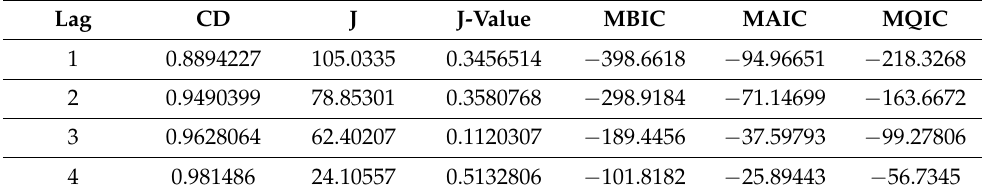
Table 6. Moment and Model Selection Criteria (MMSC) for Interest Rate Shock.